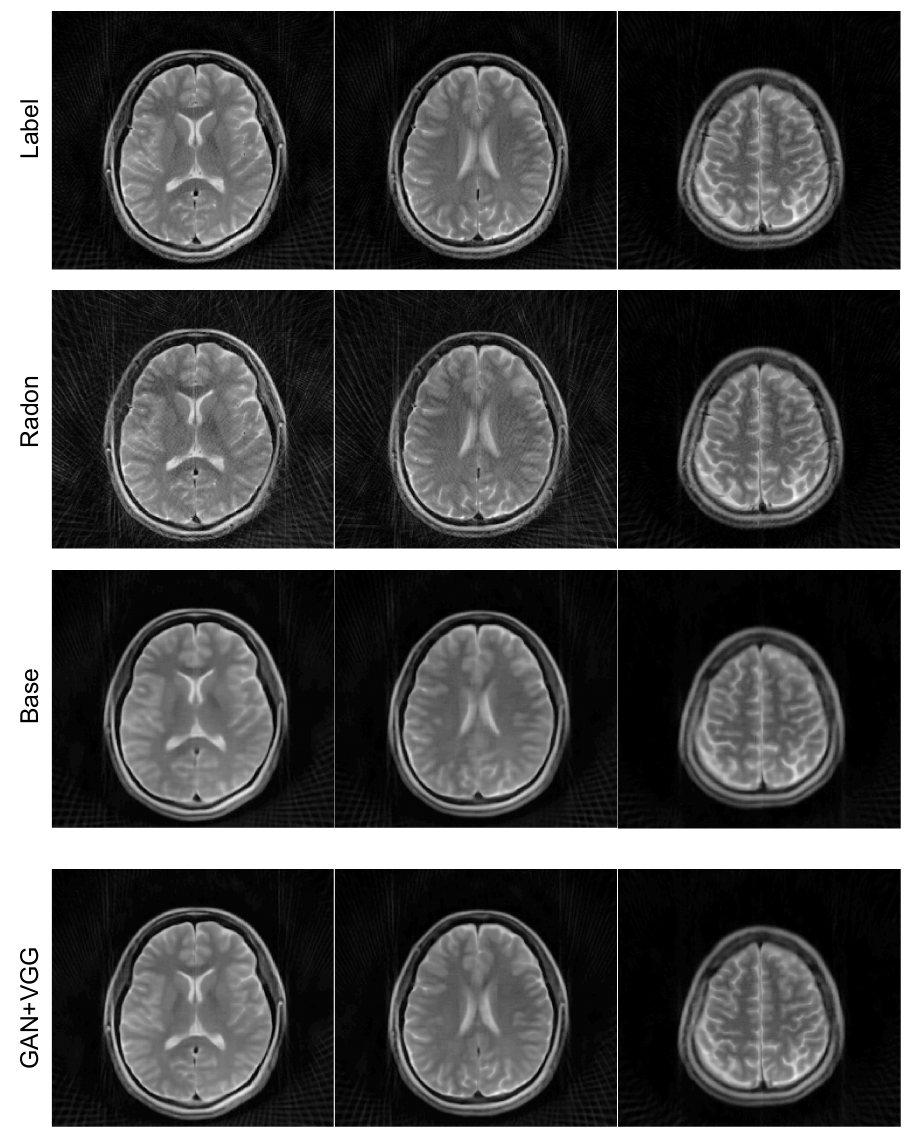
Figure 9. Comparison of inverse Radon transform with the proposed method with/without ad- ditional losses. Four example images reconstructed from radial k-space data with 100 view angles are shown. Label: reconstructed images from radial k-space data with 400 view angles by inverse Radon transform, Radon: inverse Radon transform, Base: the proposed method with the baseline loss function, GAN + VGG: the proposed method with additional adversarial and perceptual